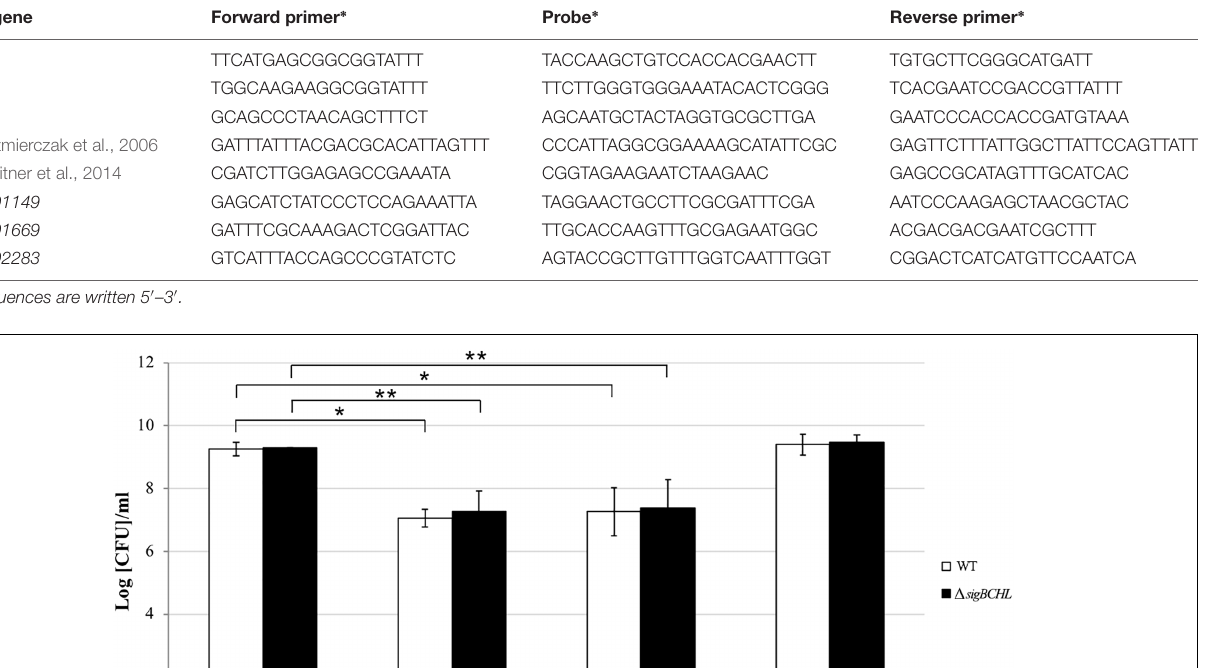
TABLE 1 | TaqMan primers and probes used for RNA-seq data validation.